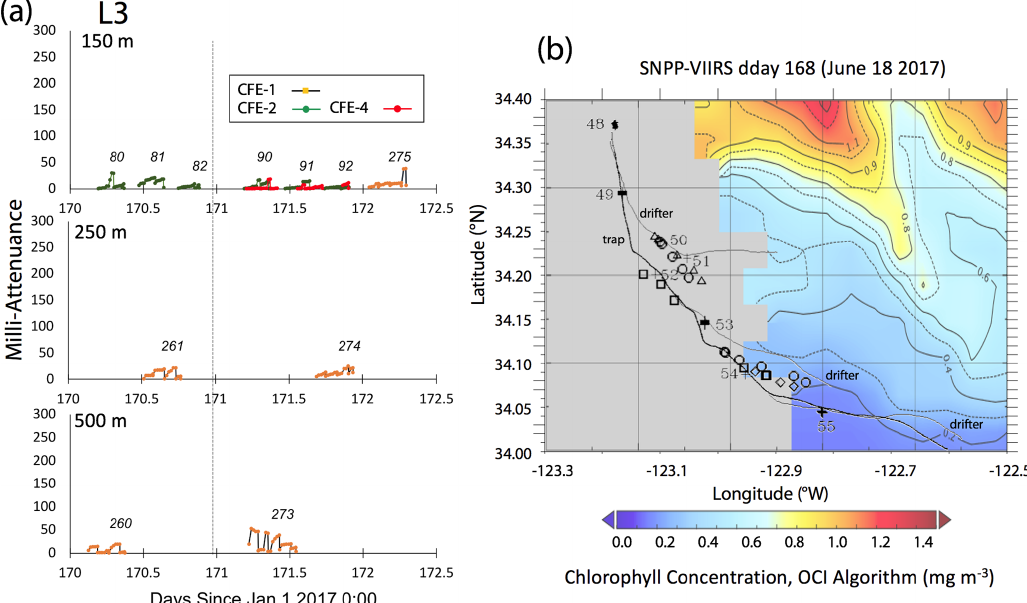
Figure A2. (a) Raw attenuance time series for CFEs deployed at L3. See Fig. 2 for deployment context. Italicized numbers are the dive num- bers corresponding to the data. (b) Map showing deployment and trajectories of CFEs, CTD station locations, and tracks of the productivity drifter and sediment trap array during the intensive studies at L3. The overlay is the SNPP VIIRS chlorophyll field for 18 June 2017 – prior to deployments. There is no contemporaneous imagery. CTD cast numbers are shown on the plot.